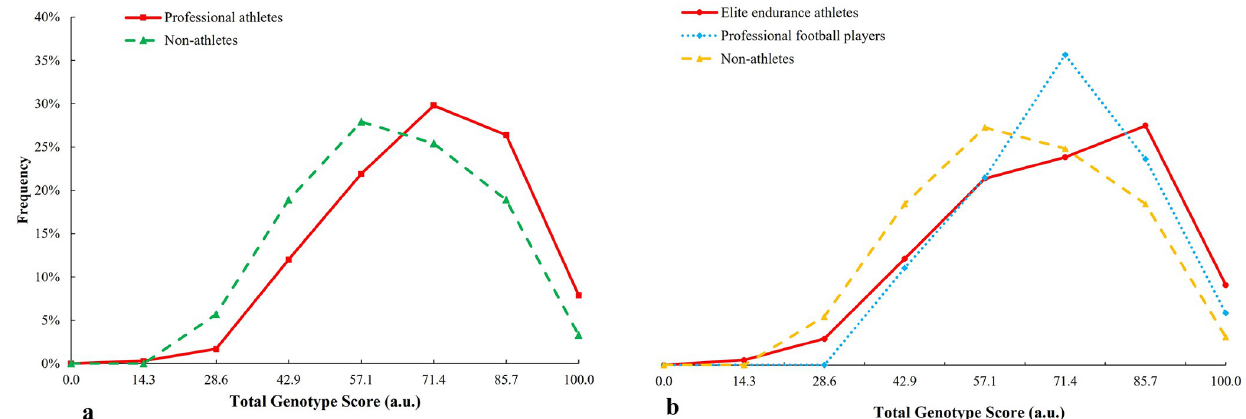
Fig 1. TGS distribution of liver metabolism genes in a) professional athletes and non-athlete subjects and b) elite endurance athletes and professional football players with regard to non-athlete subjects.